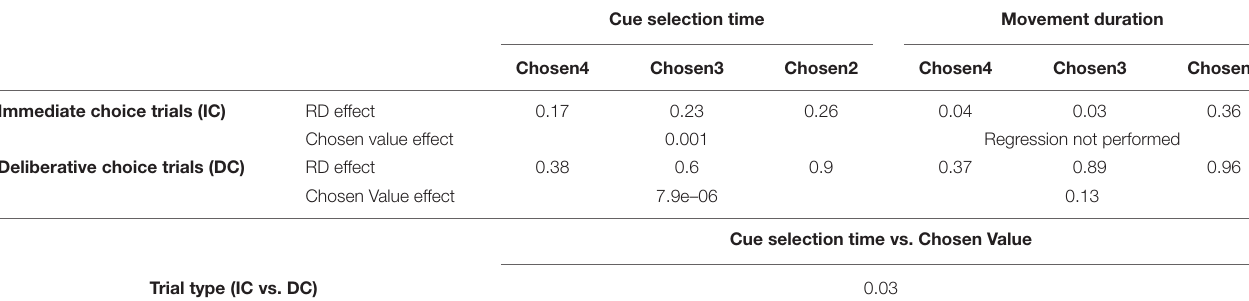
TABLE 1 | Upper table: p -values of linear regression of RD on CS time and MD for IC and DC trials (first rows) during the 3D hand tracking session. Cue selection